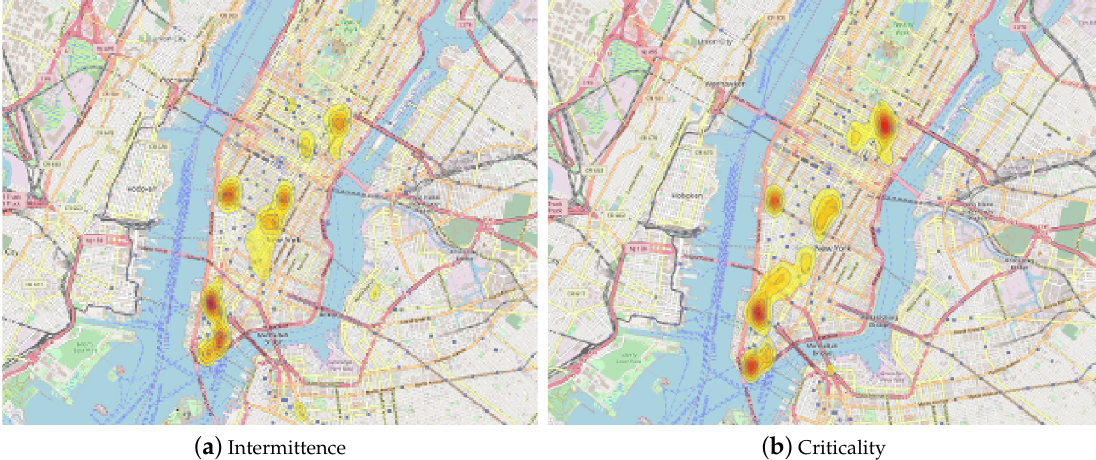
Figure 7. Heat maps representing intermittence and criticality values in New York at the hourly time slot (between 11:00 a.m. and 12:00 a.m.). maxdist = 0.5 km, and time slot size = 1 h. full-th =